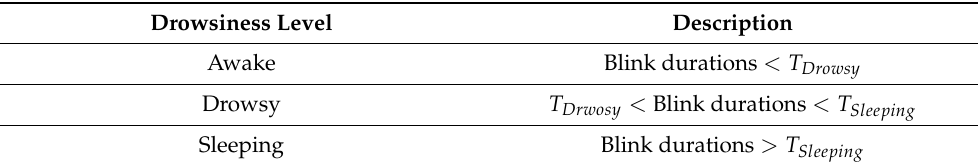
Table 1. Driver drowsiness levels ( T Drowsy = 400 ms for drowsy level and > T Sleeping = 800 ms for sleeping level) [52].